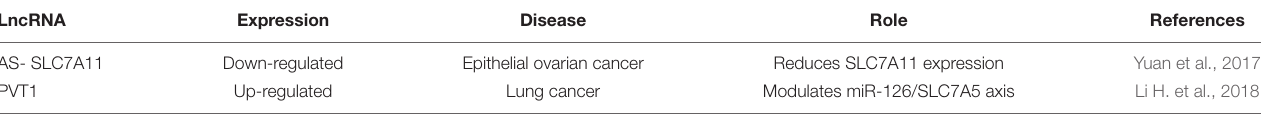
TABLE 4 | LncRNAs and their involvement in amino acids